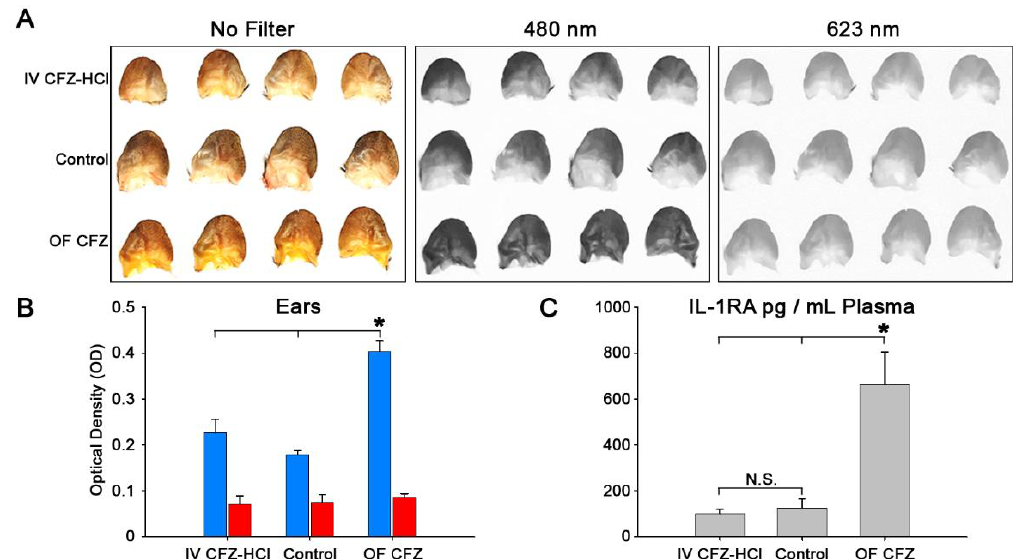
Figure 7. Quantitative analysis of skin pigmentation and plasma IL-1RA concentrations following IV administration of CFZ-HCl (IV CFZ-HCl) and oral administration of CFZ (9 week OF CFZ) compared to untreated mice (control). Images of mouse ears from treatment groups and the extent of their reflectance using 480 nm and 623 nm optical filters ( A ). Quantitative analysis of the pigmentation of mouse ears from CFZ treated mice compared to untreated mice ( n = 4) via reflectance spectroscopy (blue = 480 nm; red = 623 nm filter; * p < 0.05, analysis of variance (ANOVA) single factor, Games-Howell) ( B ). Plasma concentrations of IL-1RA in CFZ treated mice compared to untreated mice ( n = 5 (CFZ groups); n = 4 (untreated group)) (* p < 0.05, analysis of variance (ANOVA) single factor, Games-Howell) ( C ).